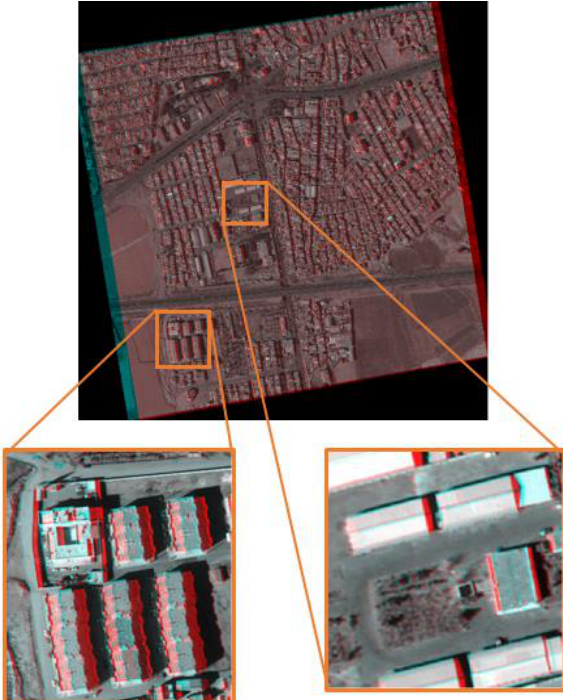
Figure 3. Stereo anaglyph of the generated epipolar images Recognition of shadow objects in the proposed method depends on the detection of suspected shadow pixels. Thresholding on the panchromatic band and the C 3new index are employed to this end. Thresholding on the panchromatic band detects a mixture of dark pixels including shadow pixels, asphalt road, and dark roofs. In the next step, thresholding on C 3new index improves the accuracy of suspect shadow pixels by omitting the false shadow pixels among the suspicious shadow